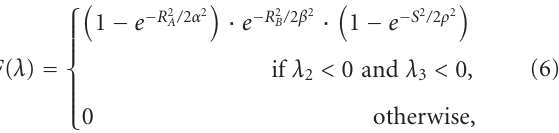
Figure 2: The vesselness images calculated from lung CT grayscale images. (a) A coronal slice of TLC data and (b) its vesselness mea- sure. Vesselness measure is computed in multiscale analysis with σ = [2,3] and rescaled to